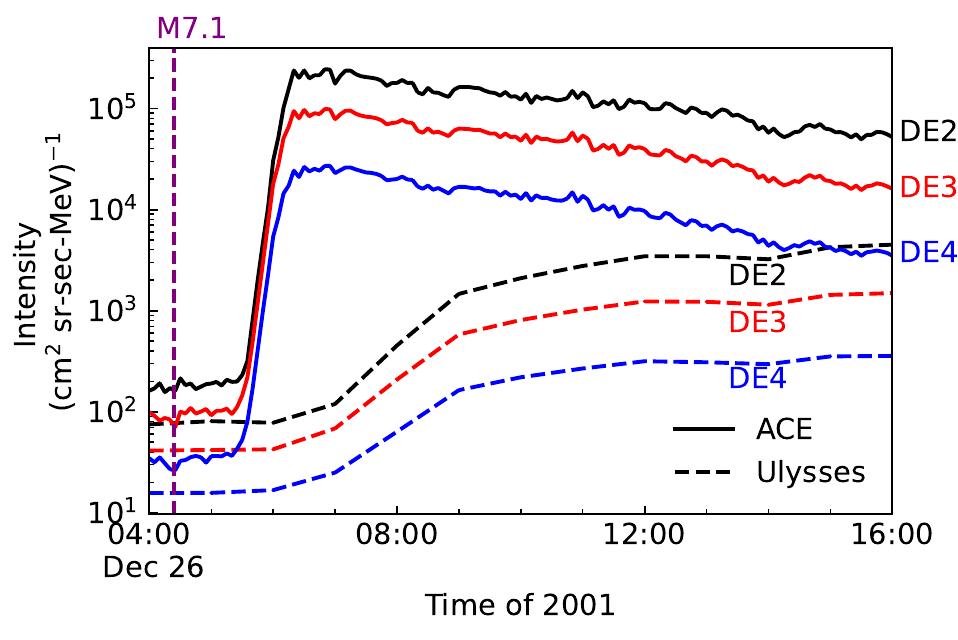
Figure 3. ACE (solid lines) and Ulysses (dashed lines) electron intensities in the DE2–DE4 energy channels for the 26 December 2001 SEP event (similar as Figure 1).